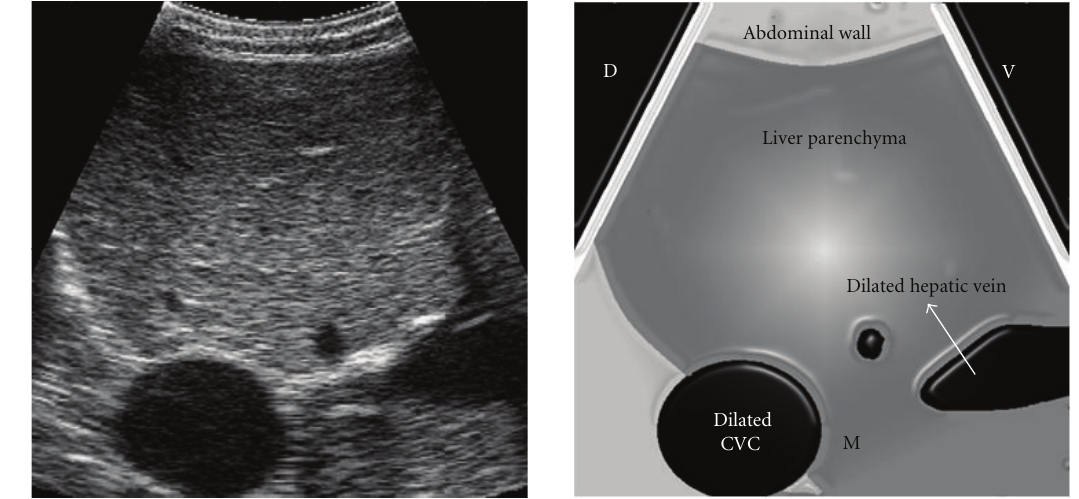
Figure 10: Ultrasonogram showing the congested CVC, obtained from the 12th ICS. CVC: caudal vena cava; ICS: intercostal space; D: dorsal; V: ventral; M: